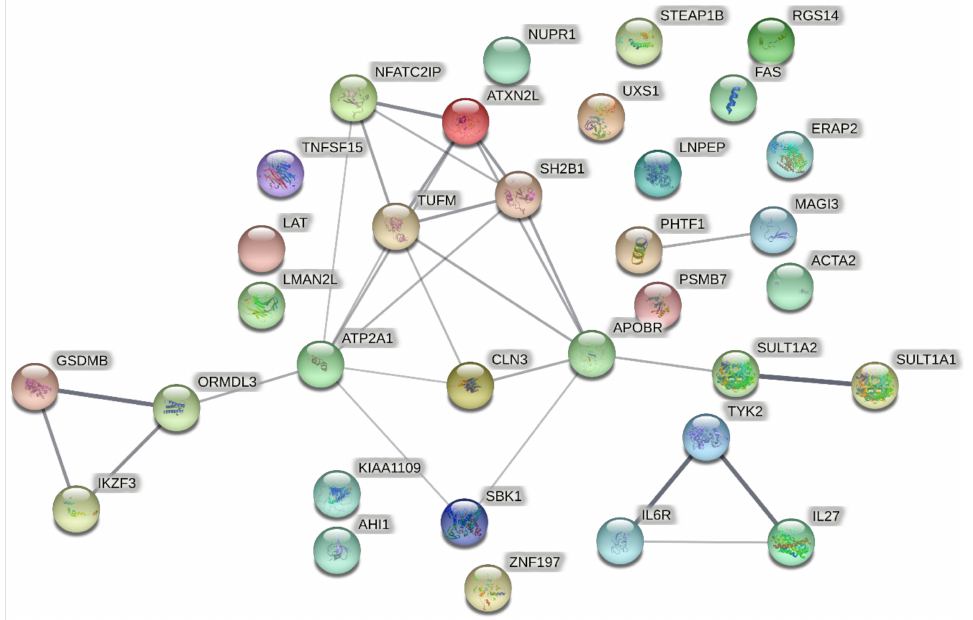
Figure 4. Protein–protein interaction (PPI) network for 33 overlapped genes by STRING. Each circle represents a protein, a line between proteins indicates PPI, line thickness indicates the strength of data